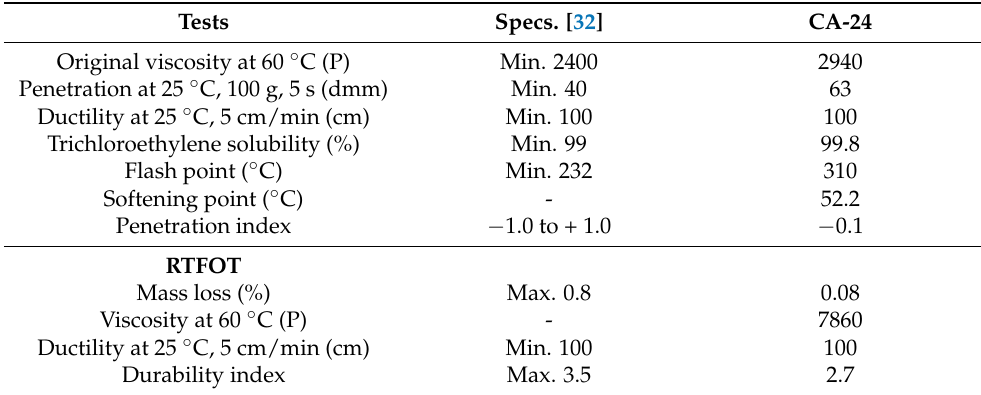
Table 1. Physical properties of reference asphalt binder